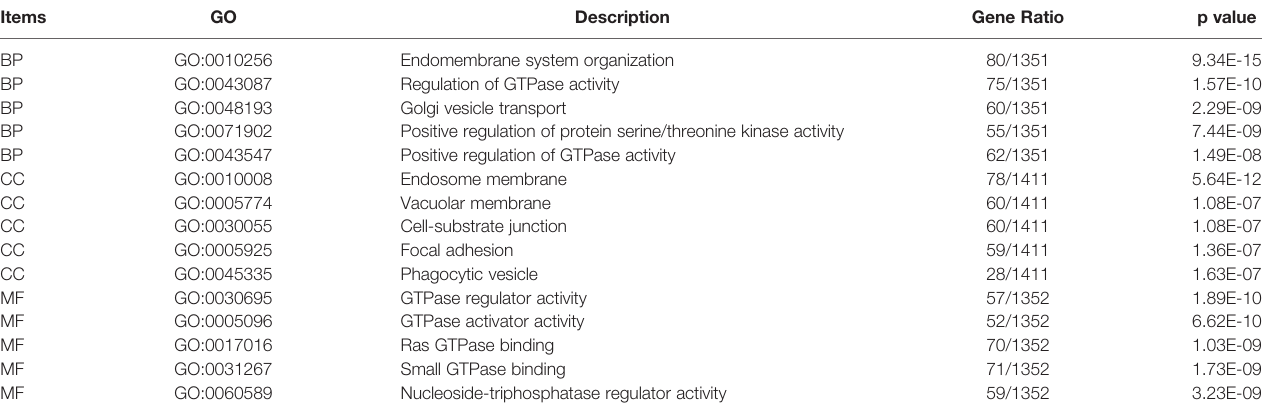
TABLE 2 | Gene oncology enrichment of co-expression genes with